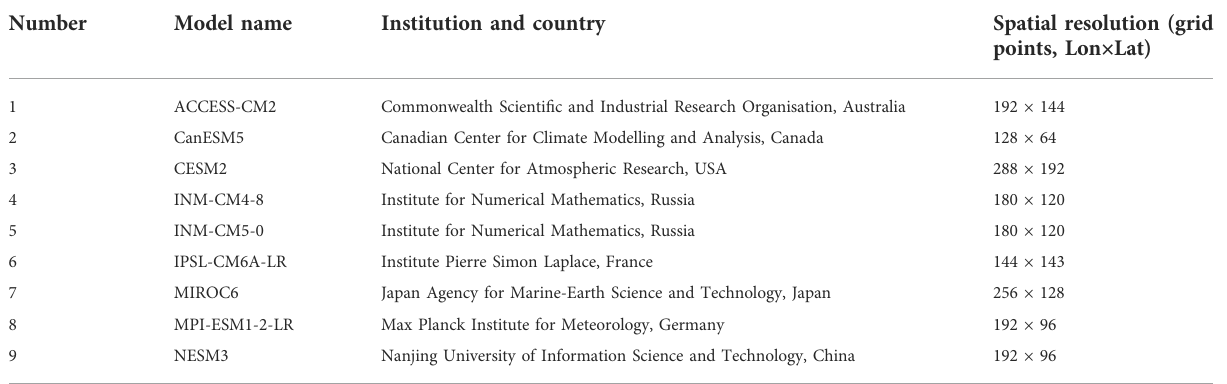
TABLE 1 Basic information of 9 models in CMIP6 chosen for future projection (the full model names can be found at https://esgf-node.llnl.gov/ search/cmip6/).